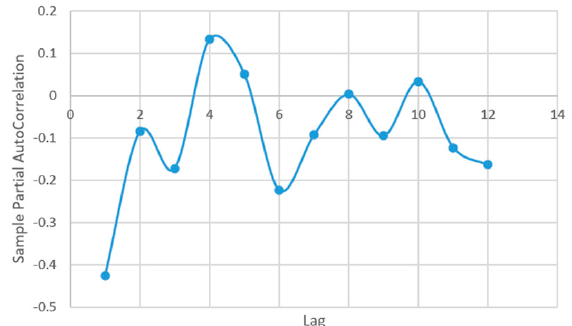
Figure A11. The AC with transformation in square roots—BR series.